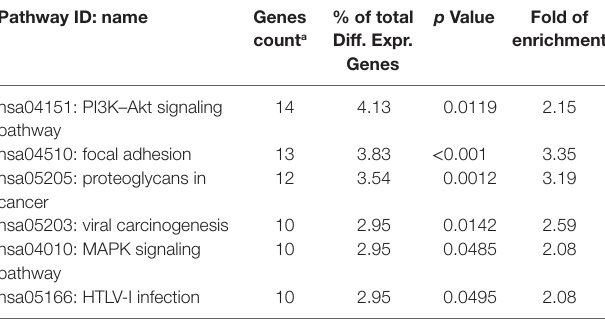
TaBle 2 | Pathway enrichment